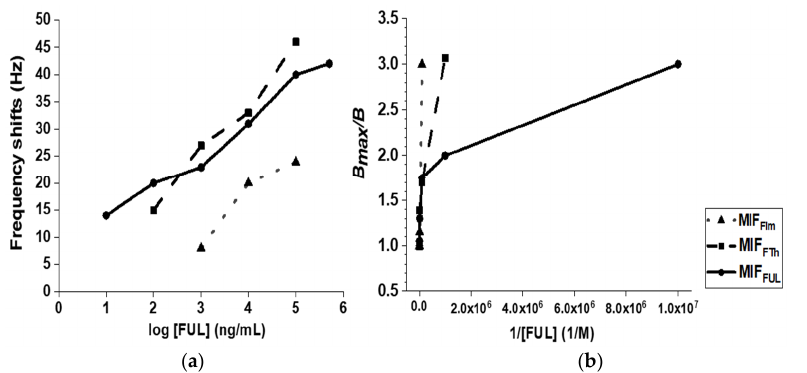
Figure 3. ( a ) The frequency-shift results and ( b ) the binding results for the FIm, FTh, and FUL templates, with a focus on the FUL binding to MIFs, as obtained from the MIF-QCM sensor. A mixed solution of heptane/acetone (95/5, v / v ) was used for circulating, washing, and testing. FIm = 2-formylimidazole; FTh = 2-formylthiazole; FUL = 2-furaldehyde.